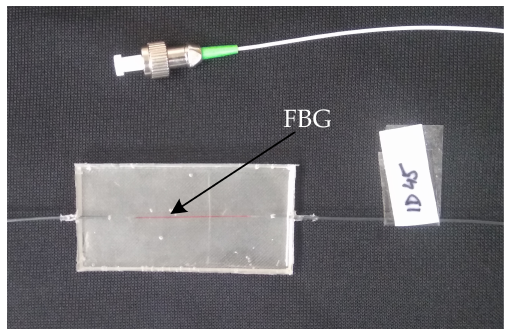
Figure 5. Fiber Bragg grating measuring probe.